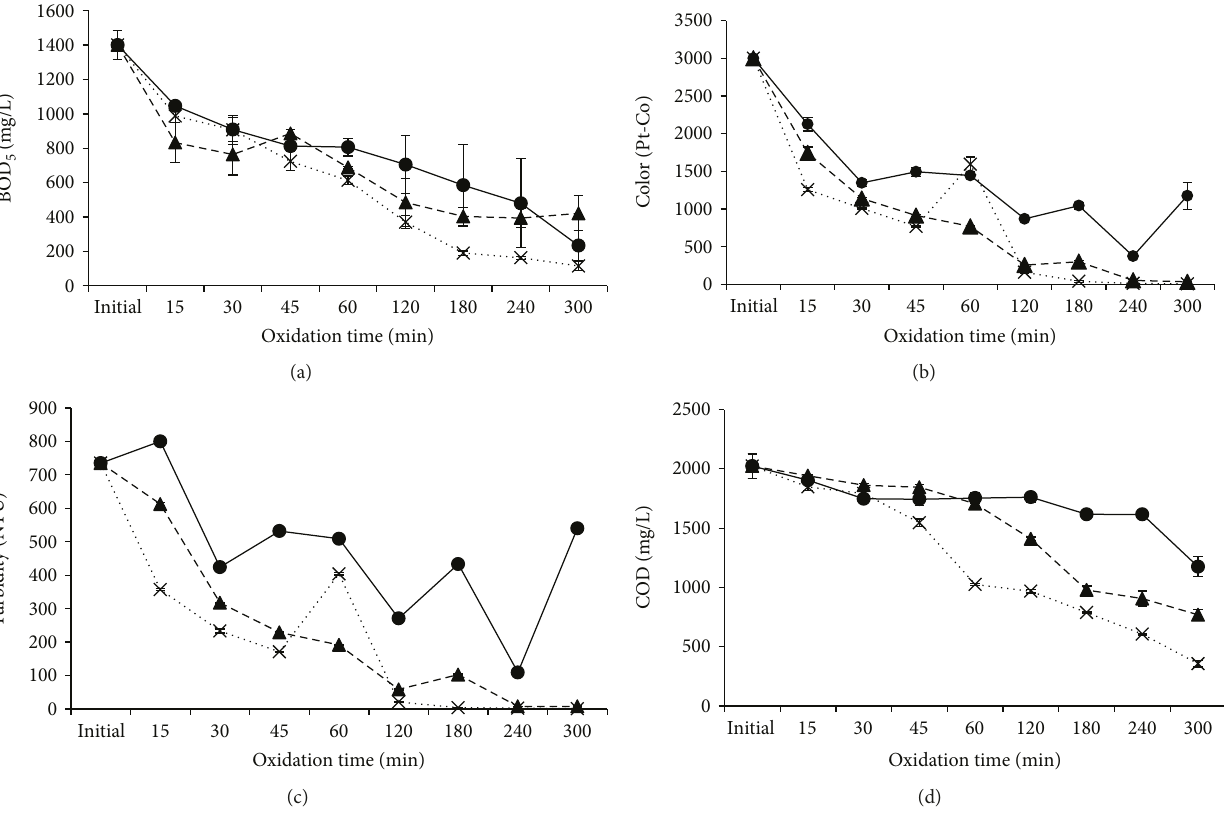
Figure 2: Behavior of (a) BOD , (b) color, (c) turbidity, and (d) COD. Applying three current densities: 3.5mA · cm − 2 ( ● ), 7mA · cm − 2 ( ▲ ), 5 and 10mA · cm − 2 (X), at pH5.23. Table 4: Removal e ffi ciencies of di ff erent parameters in the electrooxidation